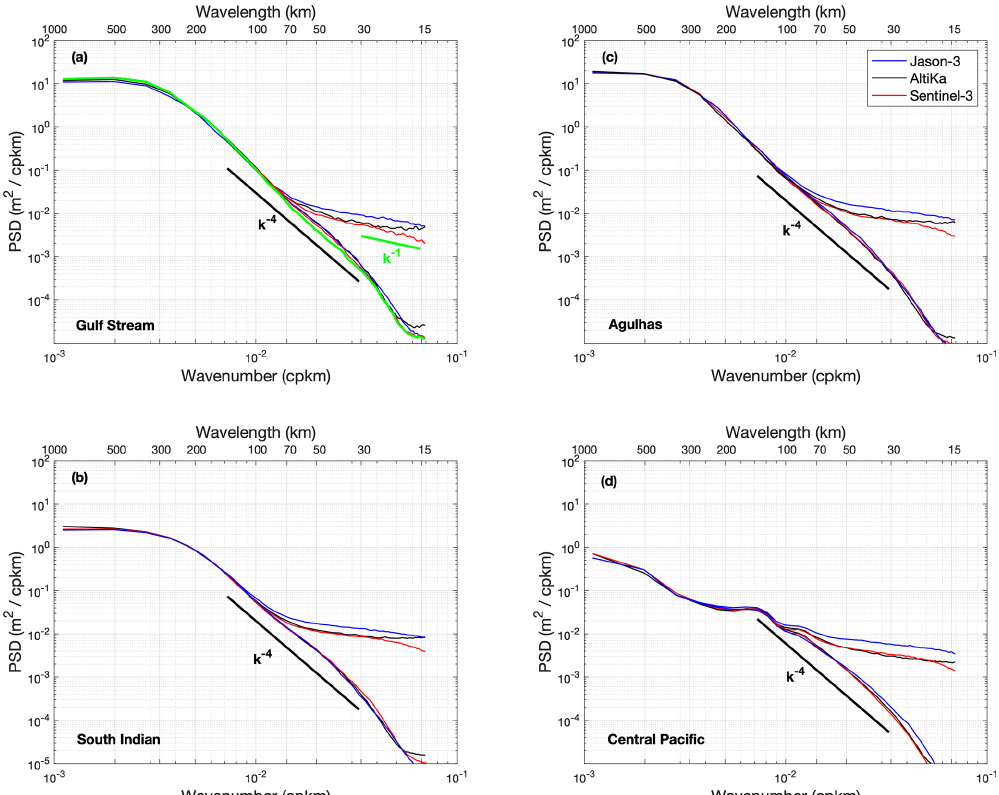
Figure 6. Mean PSD of observed and denoised SLA along-track measurements for Jason-3 (blue), AltiKa (black), Sentinel-3 (red), and four regions: Gulf Stream (panel a ; 72–60 ◦ W, 44–32 ◦ N), Agulhas (panel c ; 10–35 ◦ E, 45–33 ◦ S), south Indian (panel b ; 80–110 ◦ E, 60–40 ◦ S), and central Pacific (panel d ; 170–150 ◦ W, 10 ◦ S–10 ◦ N). The PSD is the average of PSDs computed over all data segments covering the years 2016–2018. For illustration, the green curve in panel (a) shows the PSD of denoised Sentinel-3 SLA when processed with EMD and the hypothesis of a Gaussian noise following a k − 1 slope (pink noise, Hurst exponent = 1, shown as a green solid line in the range of 15–30km). The dark solid line shows a k − 4 slope in the range of 30–150km.